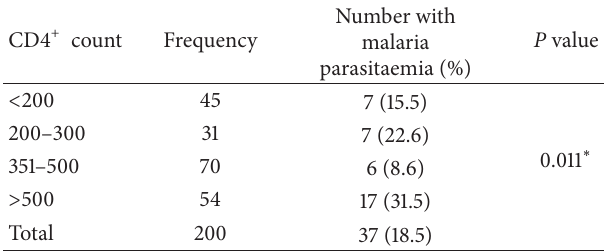
Table 4: CD4 count level and the prevalence of malaria among HIV